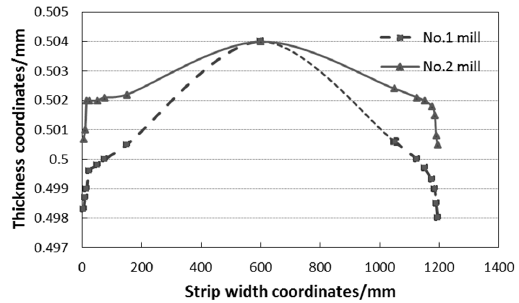
Figure 11. Typical section shape comparison of strip produced by different mills.